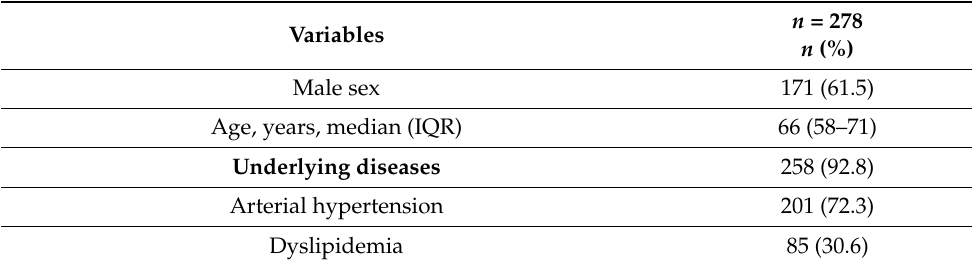
Table 1. Demographic characteristics, clinical characteristics, and mortality of 278 episodes of acute graft pyelonephritis with bacteremia in 214 KT